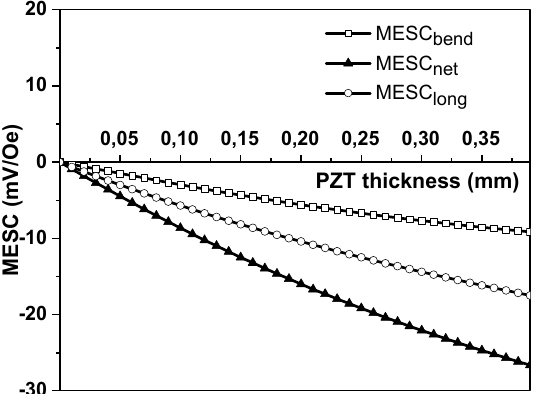
Figure 3. Estimated dependence of MESC in a Ni-PZT-Metglas first-type three-layered structure on the PZT layer thickness. The Ni layer thickness 𝑡 (cid:3040)(cid:2869) = 0.2 mm , the Metglas thickness 𝑡 (cid:3040)(cid:2870) = 0.2